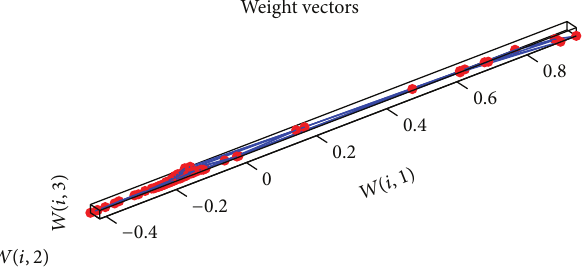
Figure 13: Training weights of SOM neural network optimized by PSO algorithm.